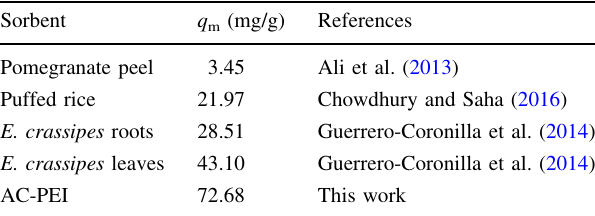
Table 2 Comparison of adsorption capacity of AM with sorbents reported in literature